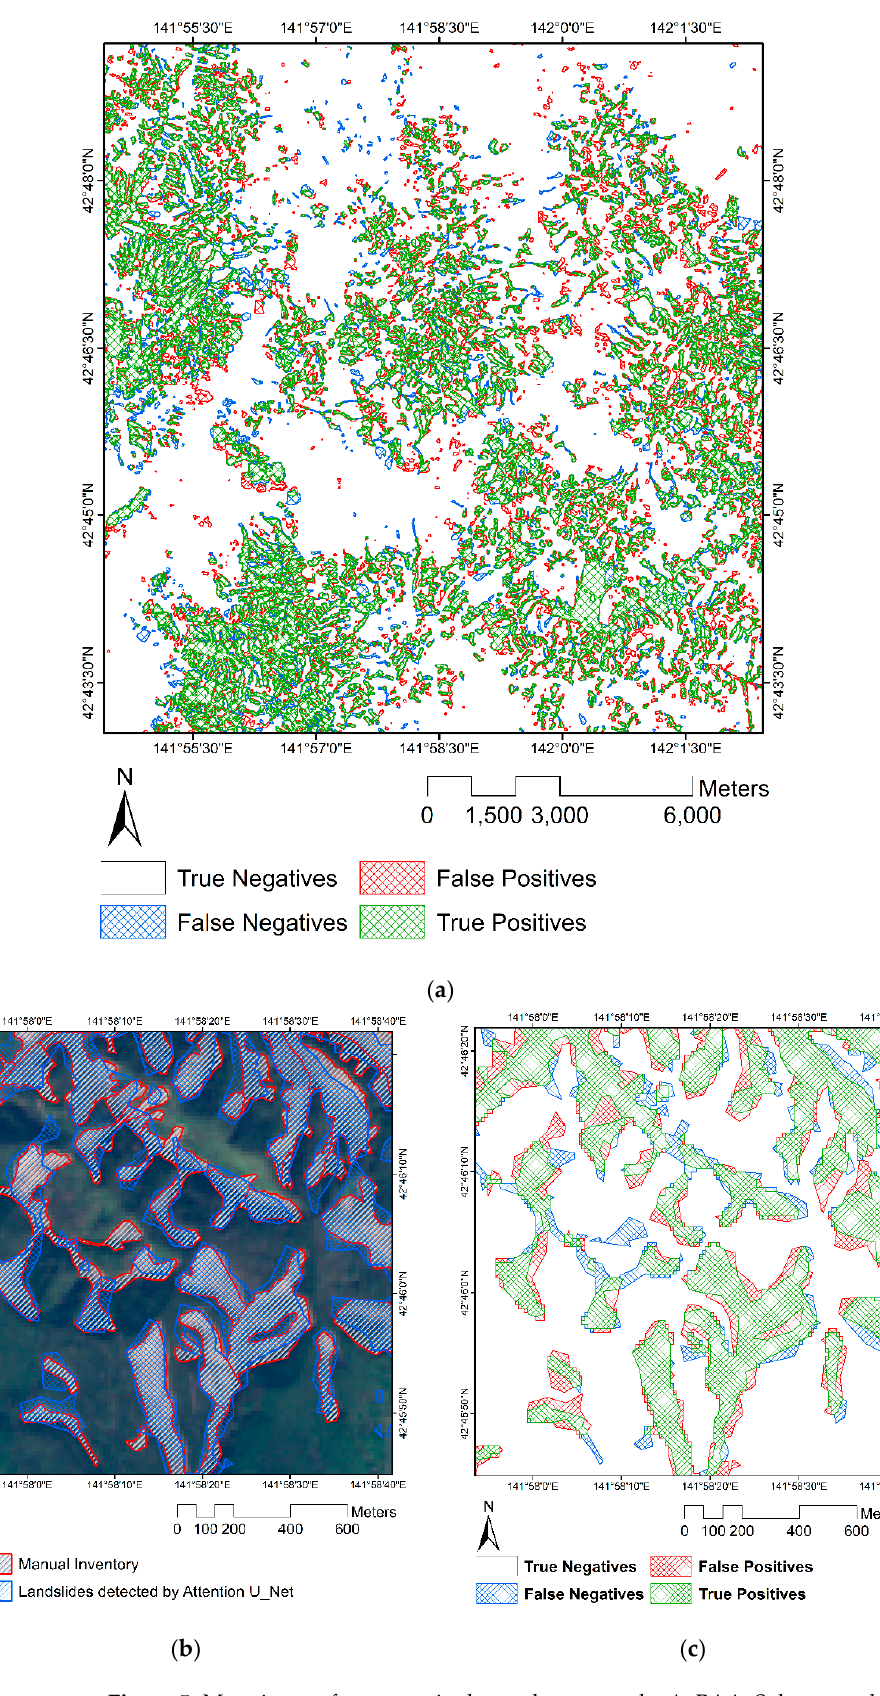
Figure 5. Mapping performances in the study area on the A_BAA_S dataset, where ( a ) shows the